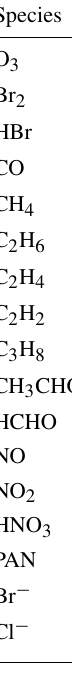
Table 2. Initial trace-gas concentrations.